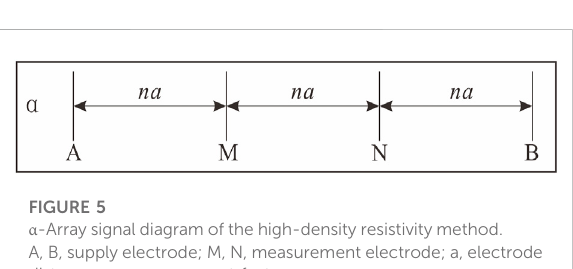
FIGURE 5 α -Array signal diagram of the high-density resistivity